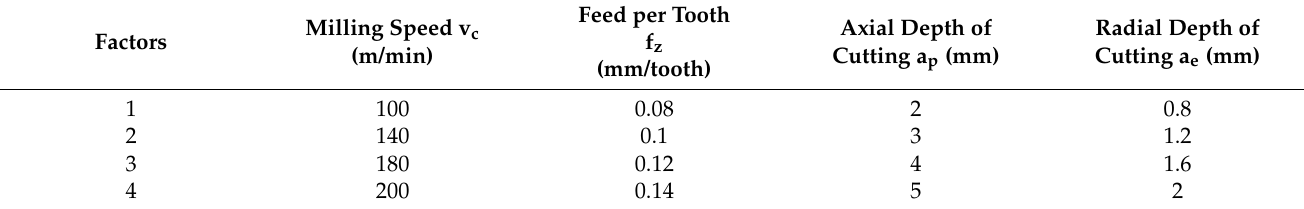
Table 1. Level table of factors.